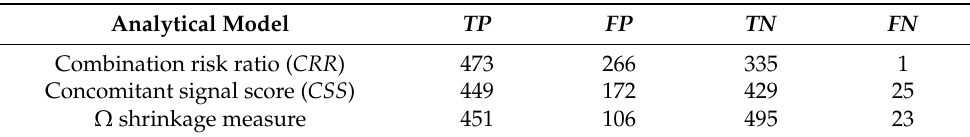
Table 2. The numbers of true positive, false positive, true negative, and false negative signal pairs for n 111 ≥ 3.